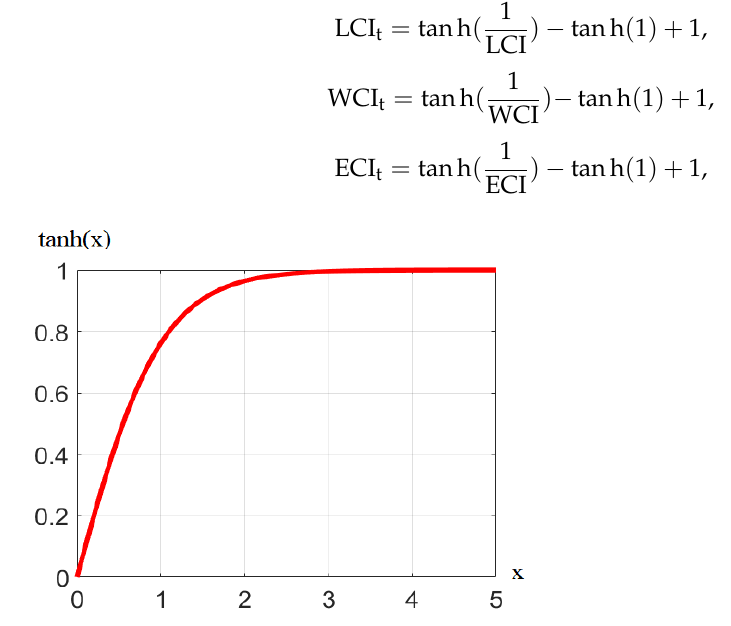
Table 1. Weights of three carrying indexes Stage of urbanization process.